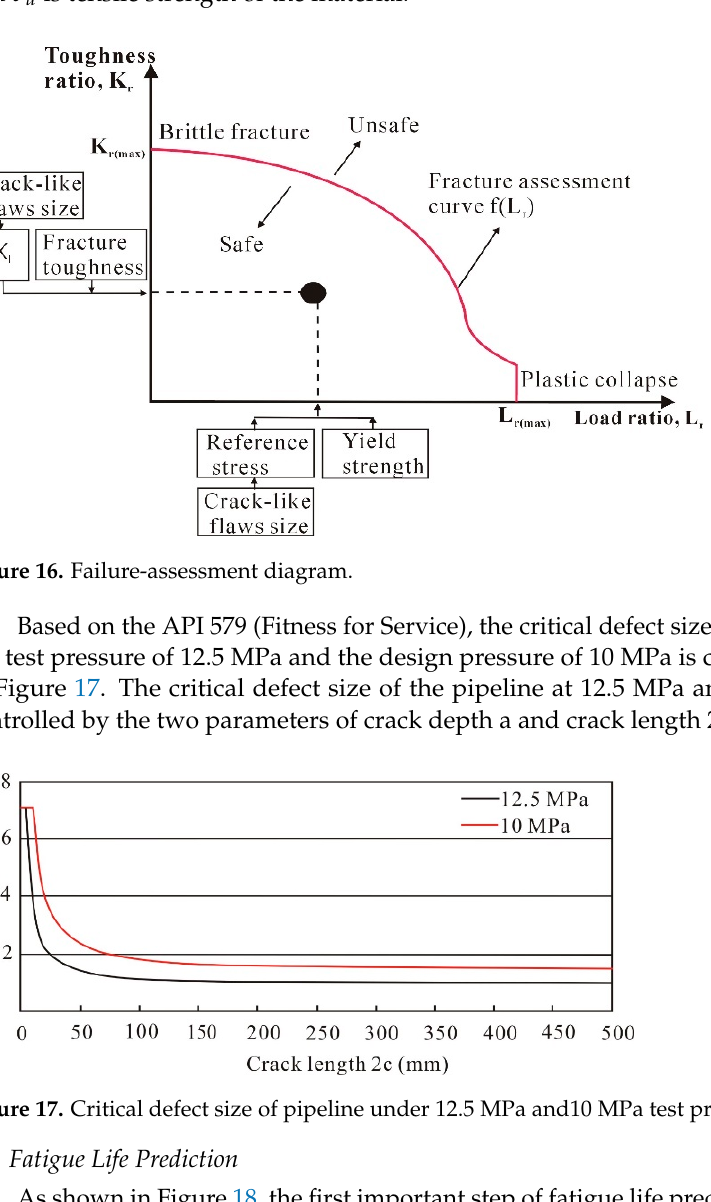
Figure 17. Critical defect size of pipeline under 12.5 MPa and10 MPa test pressure .